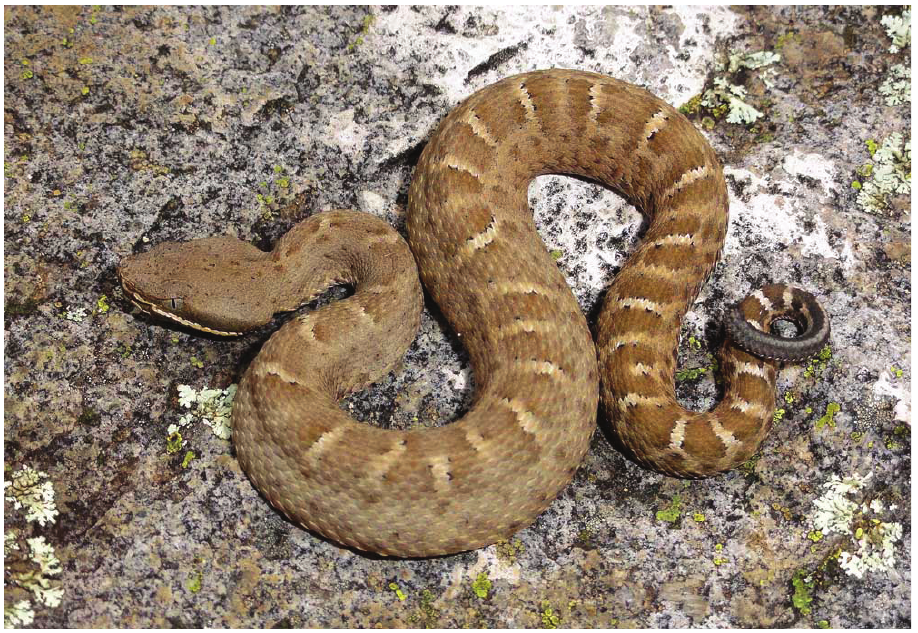
Figure 5. Crotalus willardi . Sierra del Nido, Chihuahua. Photo courtesy of Robert